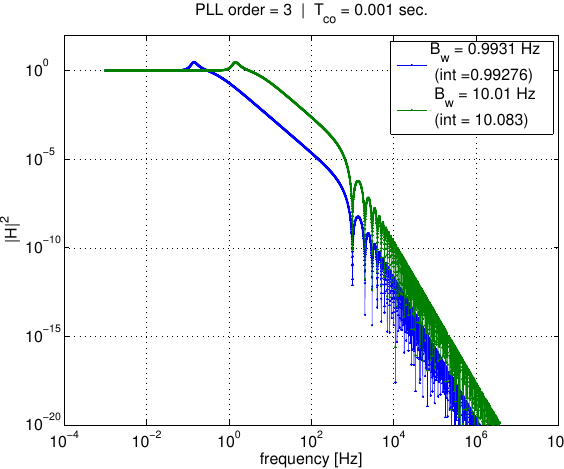
Figure 4. Effect of T co and PLL bandwidth on input–output transfer function, 1 ms.